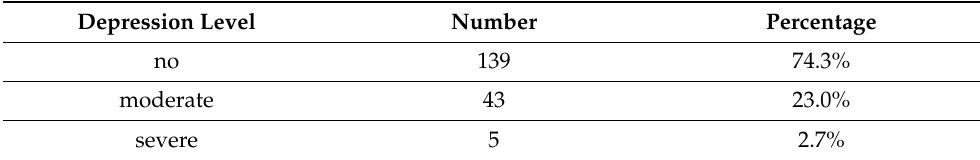
Table 6. Classification of depression level according to